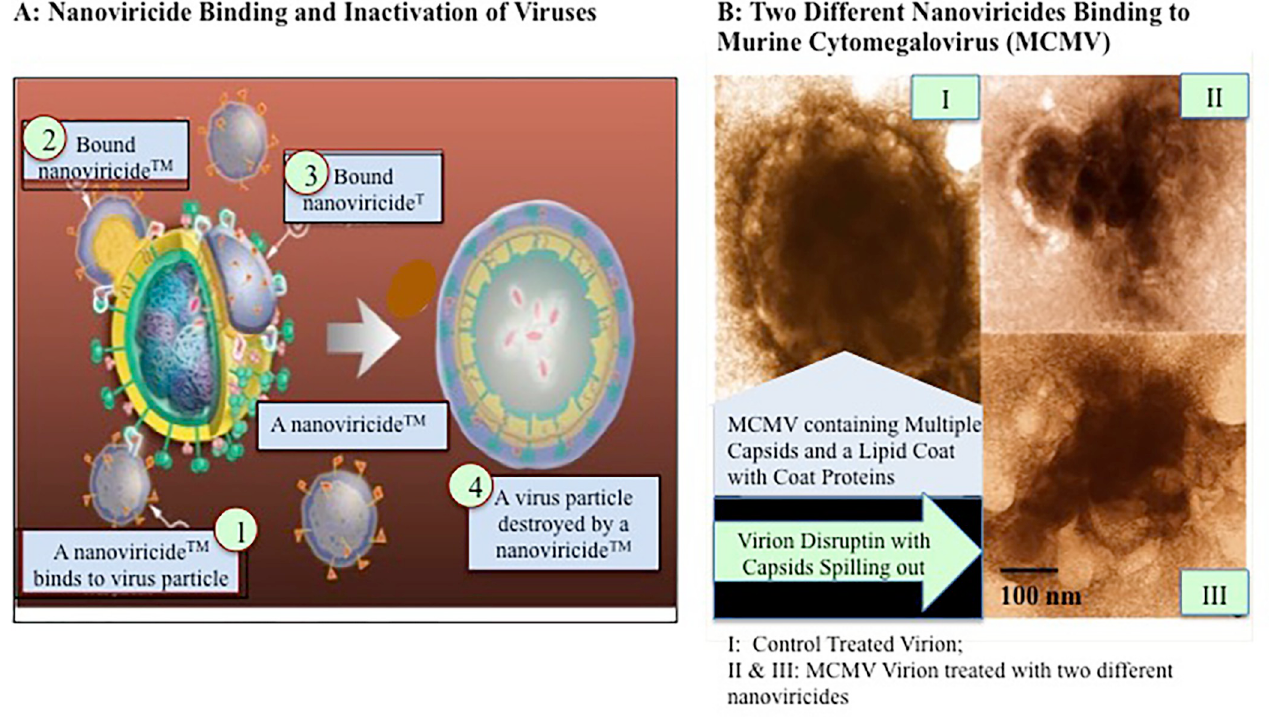
Fig 6. Graphic representation of mechanism action of nanoviricide.